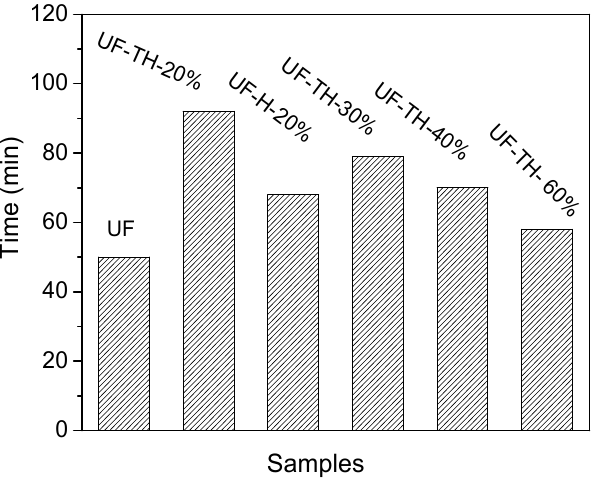
Figure 7. Water resistance of plywood samples with the addition of UF nanocomposites. The water resistance was reduced by 45.7%. This percentage was higher than 35% reported by Hosseyni [63].